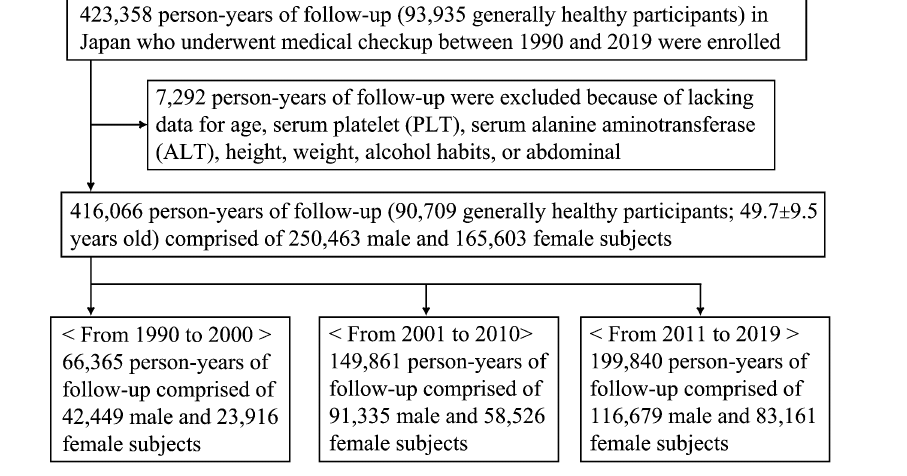
Figure 1. Flowchart of participant recruitment in the present